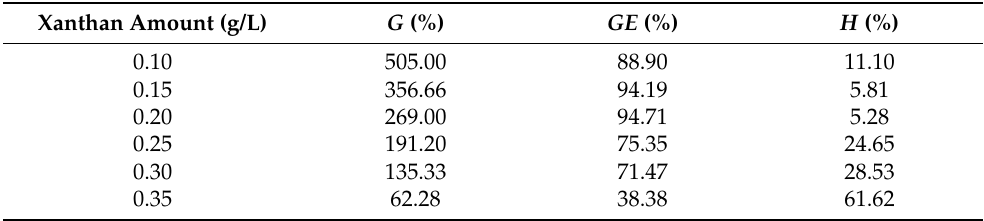
Table 4. Effect of xanthan amount on grafting parameters (Power = 750 Watt; t = 100 s.; mAAm = 8.0 mmol).